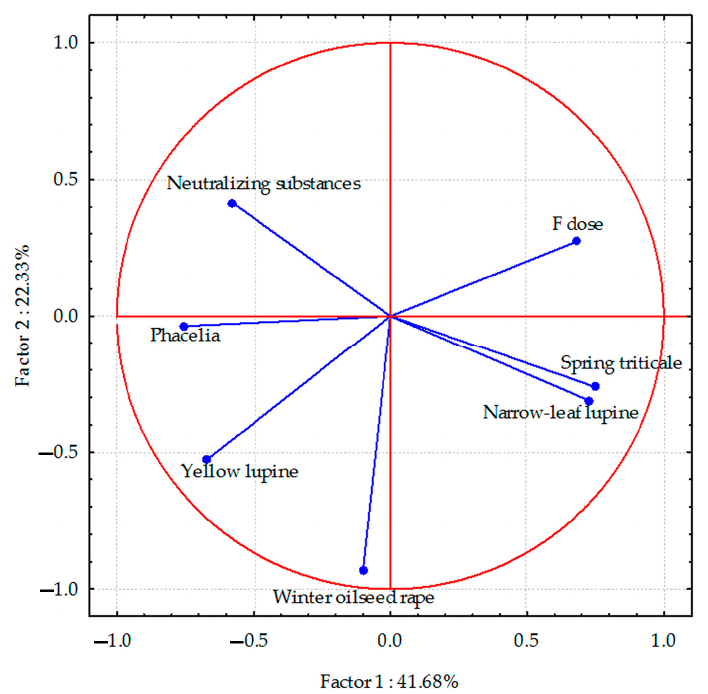
Figure 3. Sulphur content in aerial parts of plant species calculated with PCA method. Vectors represent sodium content in aerial parts of plant species versus fluorine dose and neutralizing substances application.